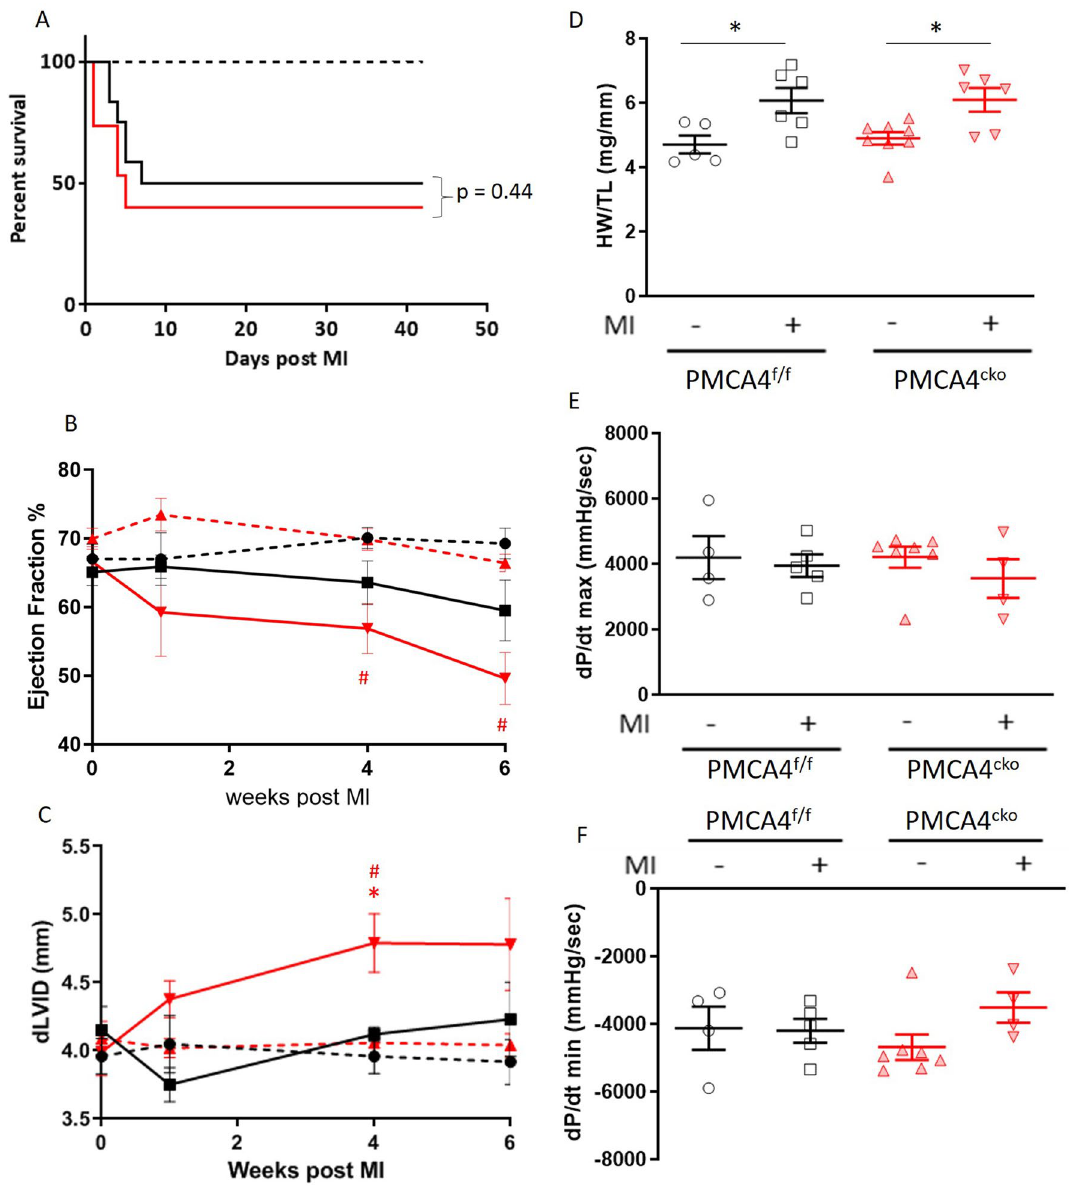
Figure 8. PMCA 4 deletion from cardiomyocytes does not affect cardiac structure or function post-MI. ( A ) Kaplan–Meier survival plots for PMCA4 flox/flox (black) and PMCA4 cko mice (red) followed for 6 weeks post MI (solid lines) or sham (dashed lines) surgery. Starting populations: control sham n = 5, control MI n = 12, PMCA4 cko sham n = 8, PMCA4 cko MI n = 15. ( B ) Ejection fraction and ( C ) Diastolic left ventricular diameter tracked for 6 weeks post-MI or sham surgery by echocardiography. # p < 0.05 versus sham control at matched time point, * p < 0.05 versus control MI at matched time point. ( D ) Heart weight/tibia length ratio 6 weeks post-MI or sham surgery. * p < 0.05 ( E ) dP/dt max and ( F ) dP/dt min 6 weeks post MI or sham surgery. control sham n = 5, control MI n = 6, PMCA4 cko sham n = 8, PMCA4 cko MI n =